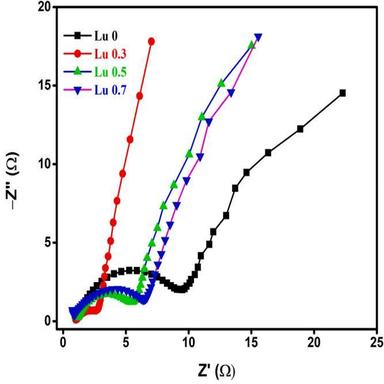
F.R.A. impedance analysis of Lu 0, 0.3, 0.5, 0.7.